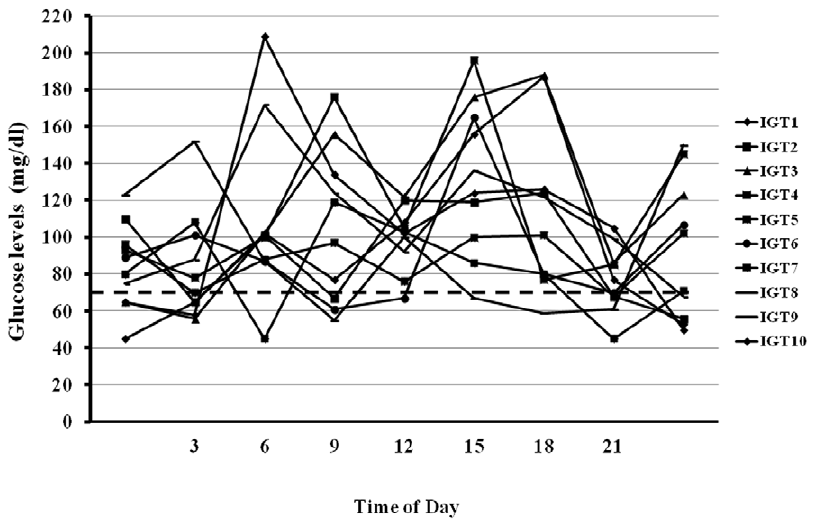
Figure 2. Twenty-four-hour glucose profiles of 10 representative individuals with IGT. Dashed line indicates the 70 mg/dl glucose threshold.